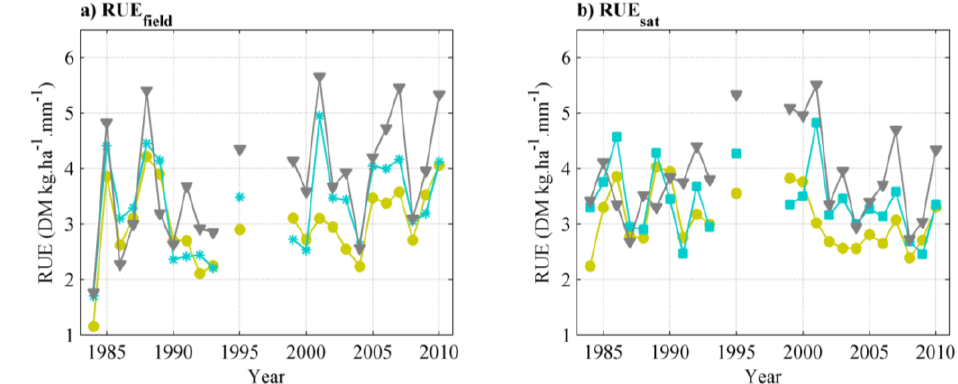
Figure A2. ( a ) RUE , ( b ) RUE , ( c ) field residuals and ( d ) satellite residuals estimated field sat using the three different rainfall datasets (field network in green, Hombori and Gourma-Rharous rain gauges in blue, and TAMSAT gridded product in